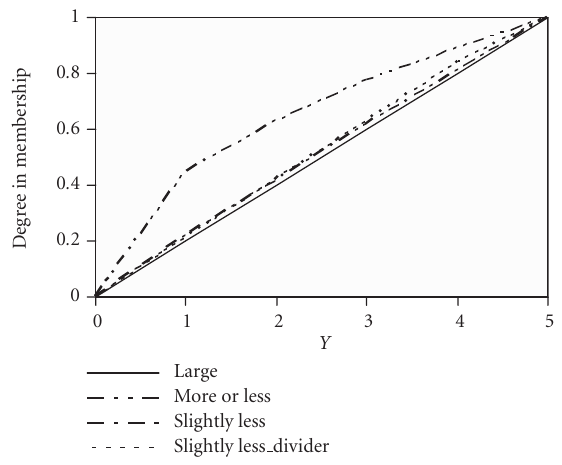
Figure 3.9. Schematic illustration of linguistic hedge “slightly